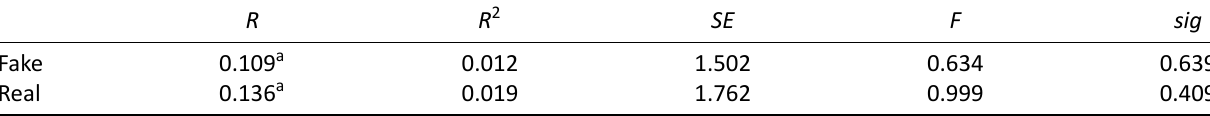
Table 5. Multiple linear regression analysis results related to different IPs in determining the believability.